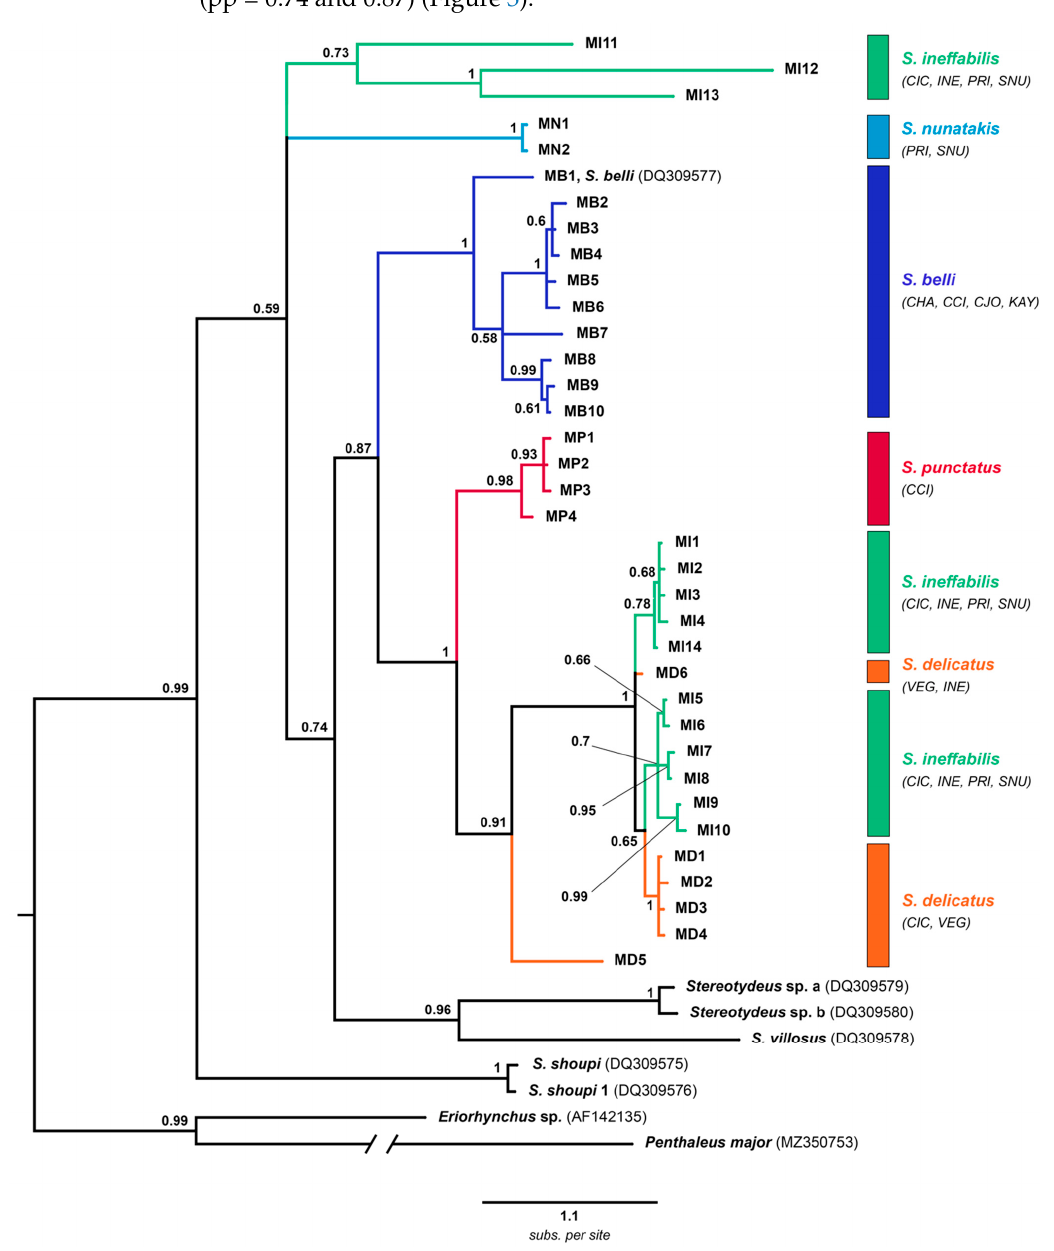
Figure 3. The phylogenetic tree of the cox1 dataset of Stereotydeus specimens from Victoria Land (locality IDs are shown in brackets). Posterior probabilities are shown at the nodes. Labels indicate the ID of the haplotypes (detailed description of haplotypes in Table 5). Accession numbers for reference sequences and Eriorynchus sp. [33,34,36] and P. major outgroups are also shown.